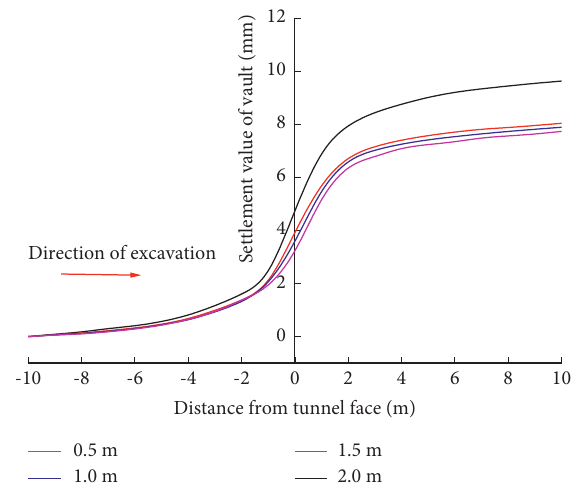
Figure 7: LDP curves under different excavation footage. (a) 0.5m; (b) 1 m; (c) 1.5m; (d)